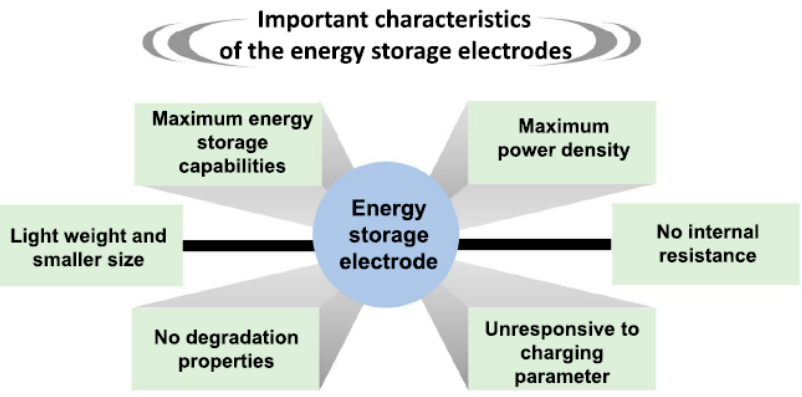
Figure 14. A few important characteristics of the energy storage electrodes. Reprinted with permis- sion from Ref. [8].